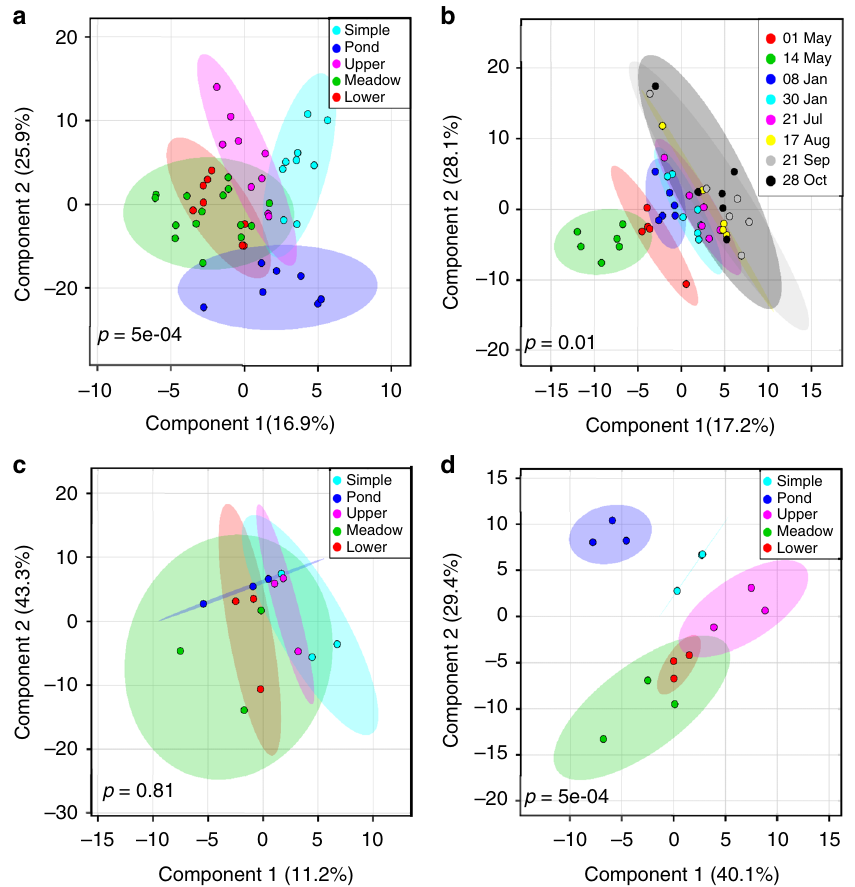
Fig. 3 Partial least squares discriminant analysis (PLS-DA) plot of metabolites. Metabolites are clustered by landscape position ( a ), sampling period ( b ), rising limb, including only May 01, May 15, and June 08 ( c ), or base fl ow, including only Aug 17, Sep 21, and Oct 28 ( d ). Each circle represents a sample and shaded ellipses represent 95% con fi dence intervals for each a priori cluster. Ellipse overlap signi fi es no signi fi cant difference between clusters. For each PLS-DA model, 2000 permutations were generated to test whether the classi fi cation systems (landscape position and sampling period) were signi fi cantly better ( p < 0.05) than those arising through random